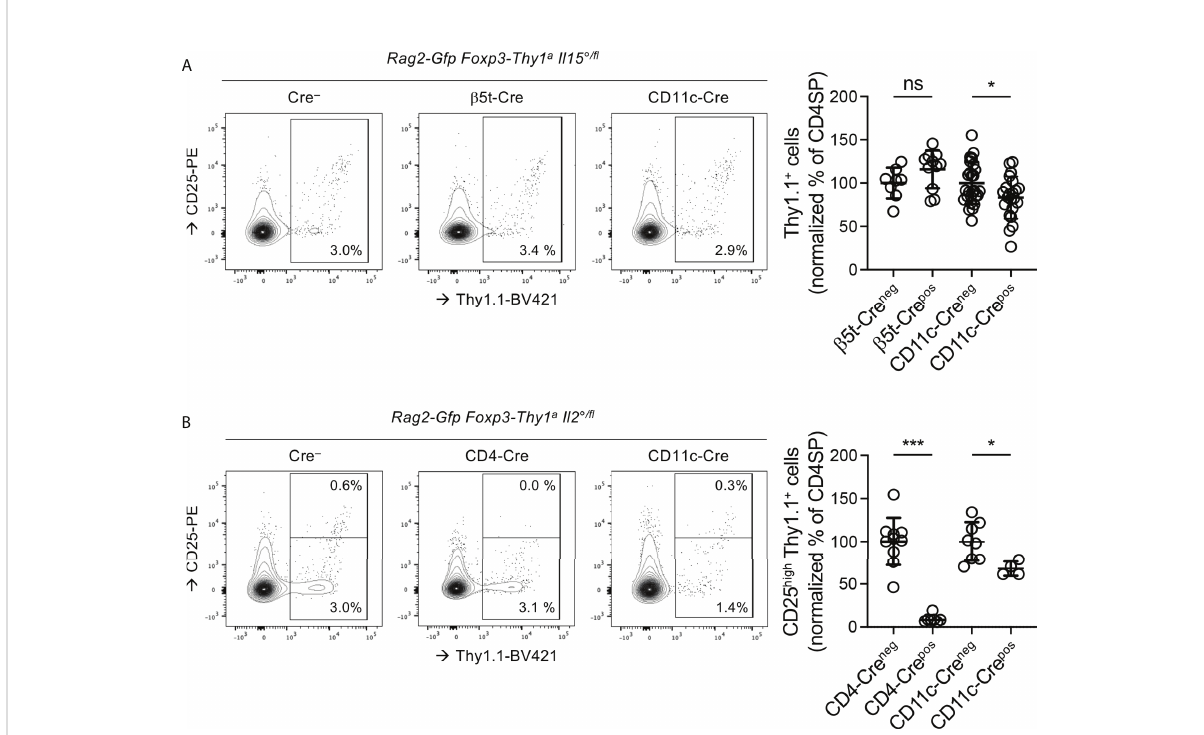
FIGURE 4 The IL15 involved in Treg development is produced by DC and the IL-2 by T cells and, to a lesser extent, by DC. Thymocytes from three-week- old Rag-Gfp Foxp3-Thy1 a mutant, (A) Il15° / fl or (B) Il2° / fl mice, expressing or not the indicated Cre-transgenes, were stained with fl uorescent antibodies against indicated markers and analysed by fl ow cytometry. (left hand panels) Representative histograms of Thy1.1 (indicating Foxp3- expression) vs. CD25 expression on GFP + (i.e. newly developed) CD4SP thymocytes (gated as in Figure S1B). Indicated gates were used for the quanti fi cation of (CD25 − /low and CD25 high ) Thy1.1 + Treg among CD4SP cells. (right-hand panels) Quanti fi cation of (A) total or (B) CD25 high Treg among GFP + CD4SP thymocytes. Dots indicate individual mice and values were normalized to the average percentages found in Foxp3 Thy1a/Y male and Foxp3 Thy1a/wt female, Cre − littermates ( (A) n=8 b 5t-Cre − , 11 b 5t-Cre + , 27 CD11c-Cre − , 22 CD11c-Cre + , (B) 10 CD4-Cre − ,7 CD4-Cre + , 8CD11c-Cre − , and 4 CD11c-Cre + mice). ns, not signi fi cant; *p < 0.05; ***p < 0.001 (Mann-Whitney test). Dots indicate individual mice. Bars indicate mean values ±